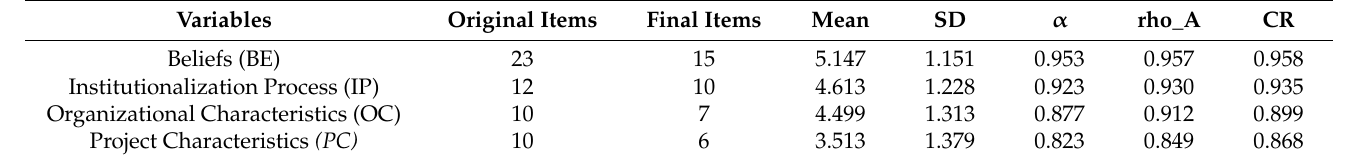
Table 1. Measurement model evaluation results.